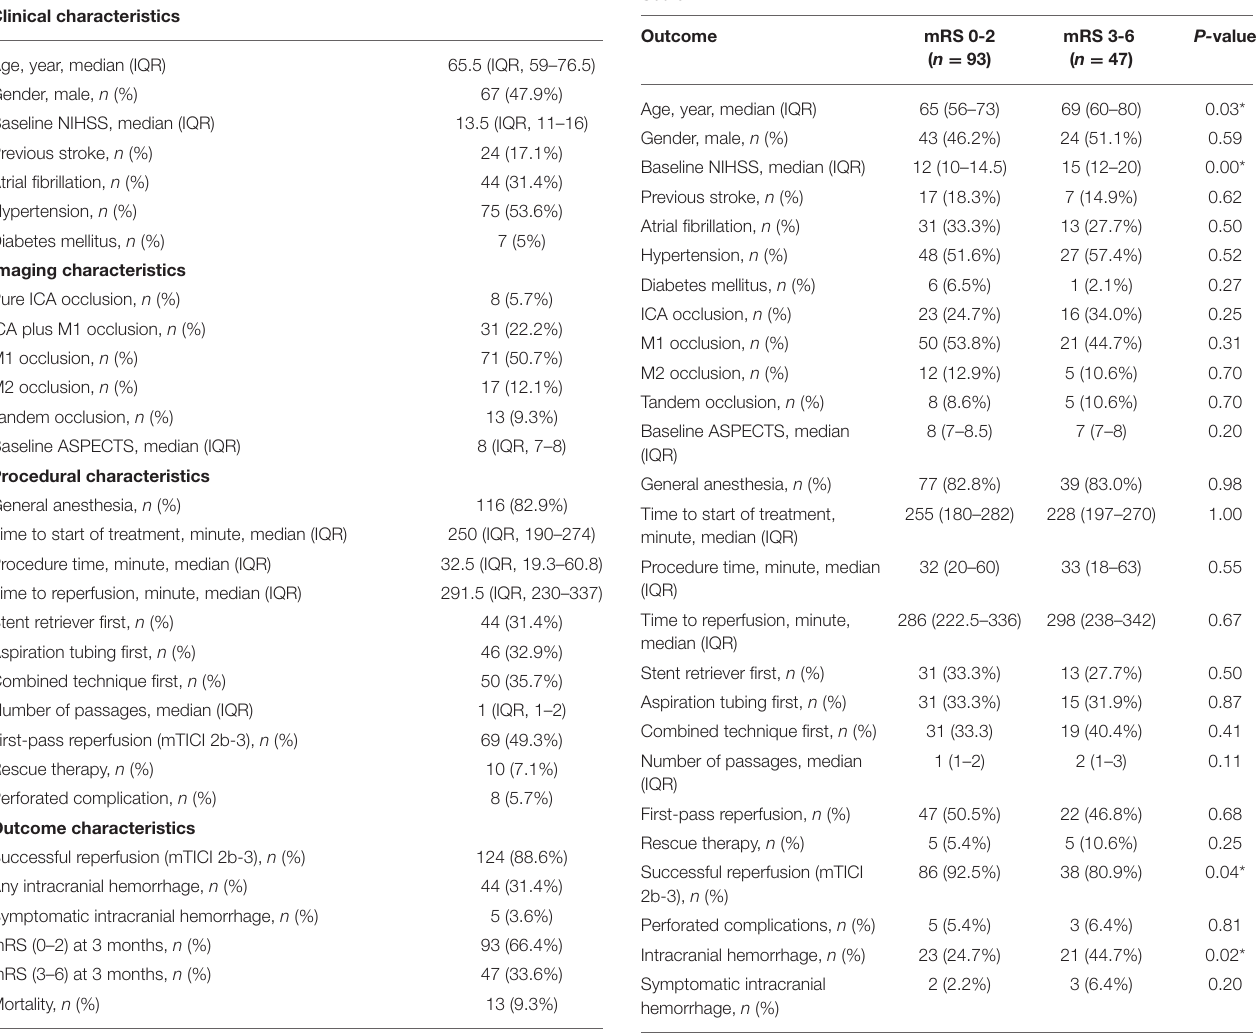
TABLE 2 | Factors associated with favorable outcome based on modified Rankin Score.